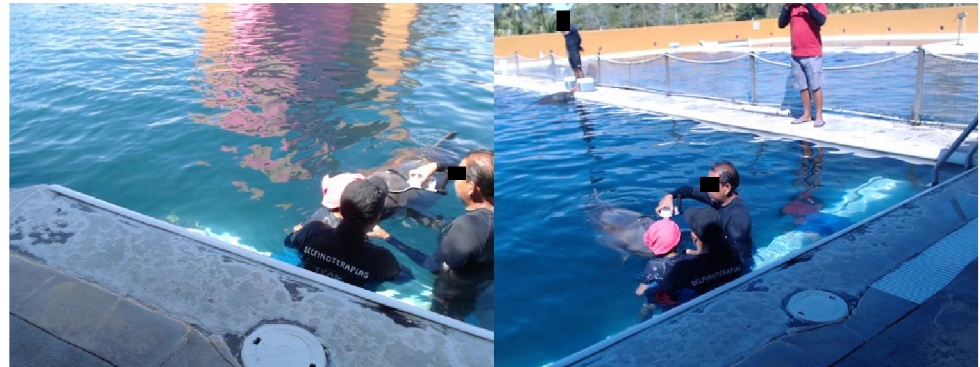
Figure 6. Placement of the device on the dolphin brain to capture the EEG Activity during a Dolphin Assisted